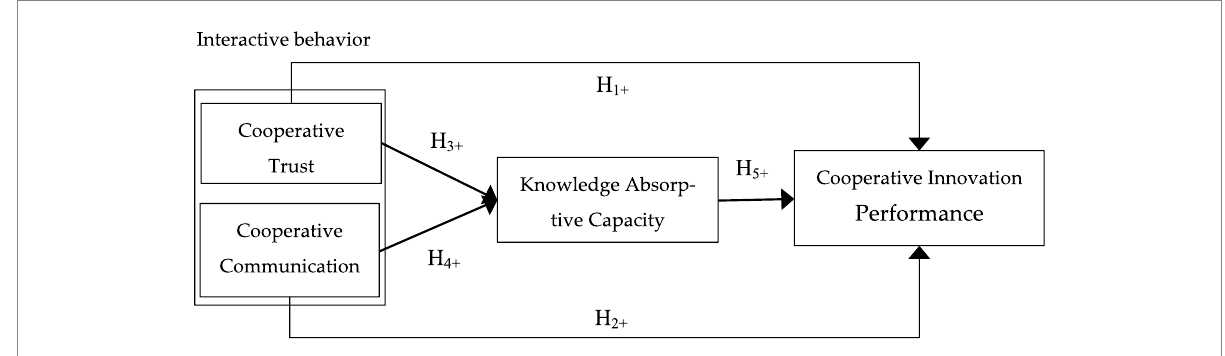
FIGURE 1 Theoretical model. [+] plus sign indicates positive relationships, and [ → ] solid line indicates direct